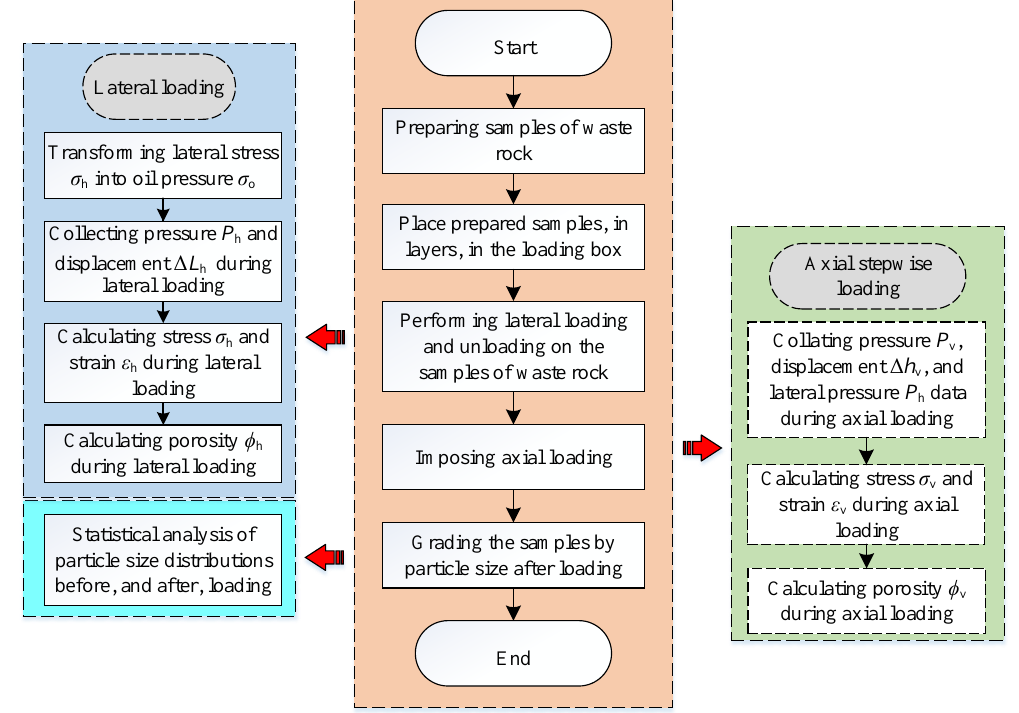
Figure 5. Flowchart through the test for the compaction characteristics of crushed waste rocks used for backfilling.